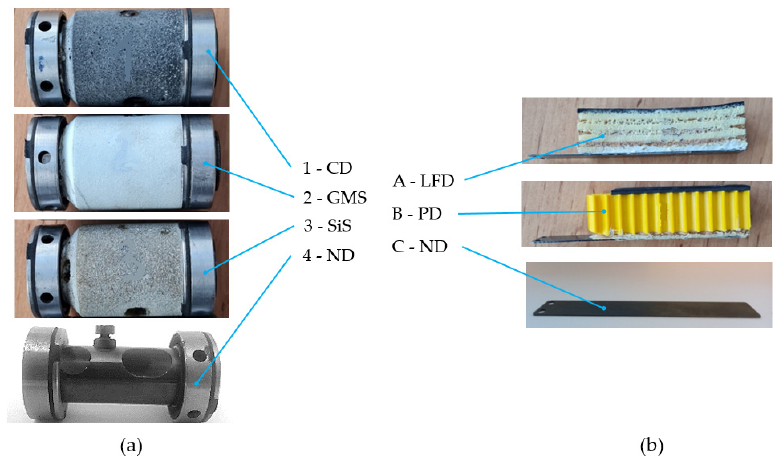
Figure 3. ( a ) Rotor casing filled with polymer matrix composites with 1-CD, carbon dust; 2-GMS, glass hollow microsphere; 3-SiS, silica sand; and 4-ND, native design ( b ) Pressure plate with A-LFD, layered foam damper; B-PD, particle damper; and C-ND, native design.